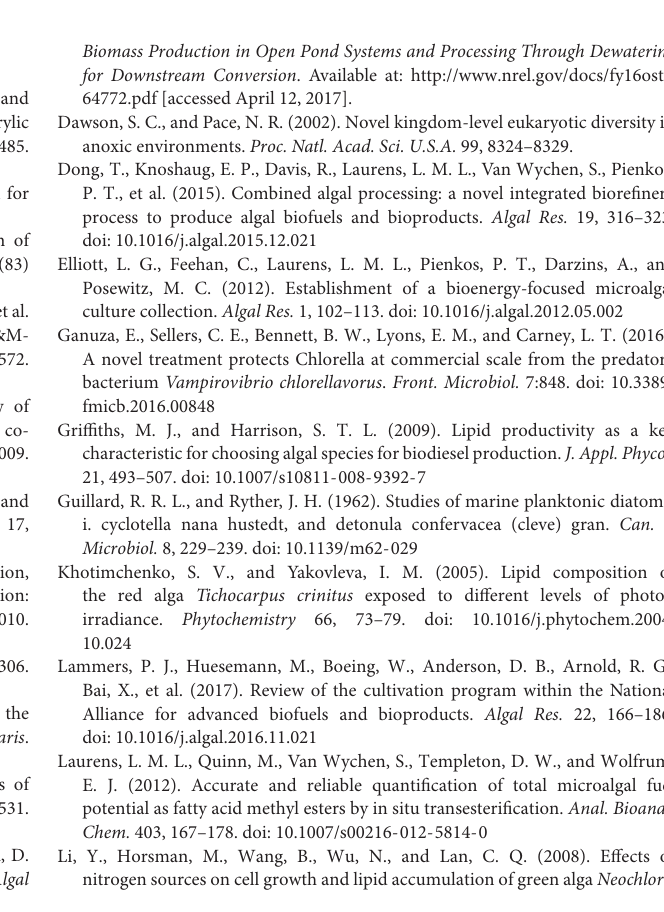
FIGURE S1 | Photobioreactor schematic for mid-throughput, simulated outdoor screening of algal cultivars. TABLE S1 | Algal down-selection